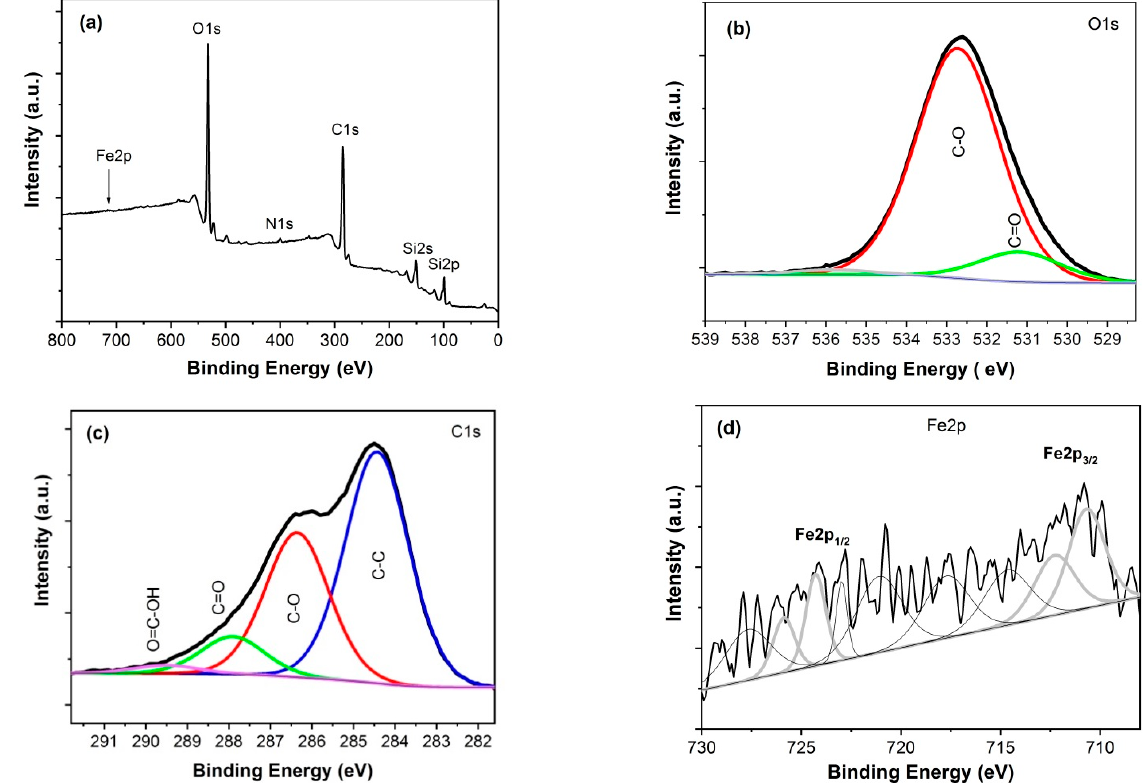
Figure 4. XPS spectra for GO/Fe 2 O 3 multilayer: ( a ) wide scan, ( b ) HR O1s, ( c ) HR C1s, ( d ) HR Fe2p.